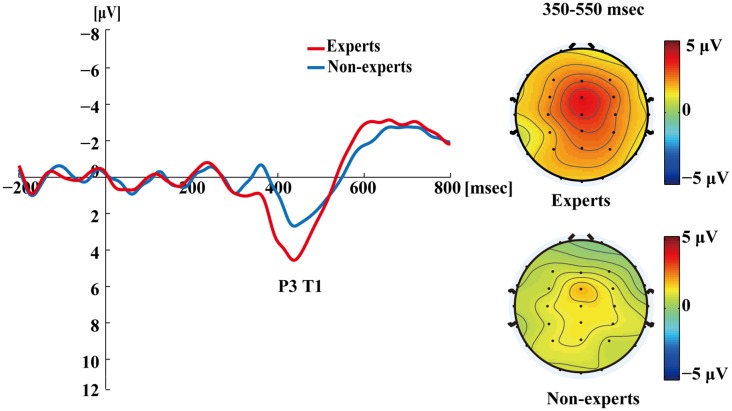
Grand averages of the mean activation at Pz of both experts and non-experts as a function of time for single-target trials. ERPs were time locked to the onset of T1. The scalp distribution of 350–550 ms time windows for single-target condition.